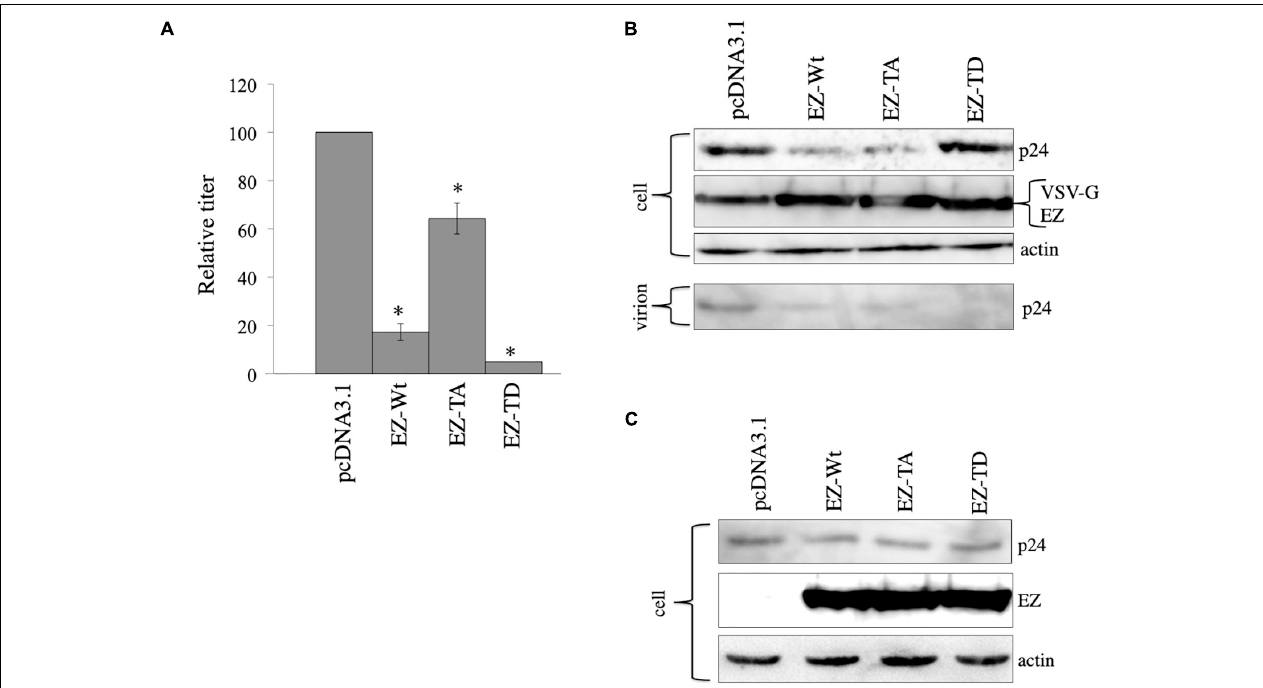
FIGURE 7 | Role of ezrin phosphorylation on VSV-G-mediated stabilization. (A) COS7 cells were transfected with the VSV-pseudotyped HIV-1 vector construction plasmids together with pcDNA3,1, EZ-Wt, EZ-TA, or EZ-TD expression plasmid. Culture supernatants from the transfected cells were inoculated to HeLa cells, and transduction titers were measured. Relative values to the transduction titers in the pcDNA3.1-transfected cells are indicated ( n = 3). Asterisks show significant differences compared to pcDNA3.1. (B) Cell lysates prepared from the transfected cells were analyzed by western blotting. HIV-1 mature capsid (p24), EZ, and VSV-G proteins were indicated. (C) COS7 cells were transfected with the expression plasmids for construction of the HIV-1 vector without any viral Env protein together with pcDNA3.1, EZ-Wt, EZ-TA, or EZ-TD expression plasmid. Cell lysates from the transfected cells were analyzed by western